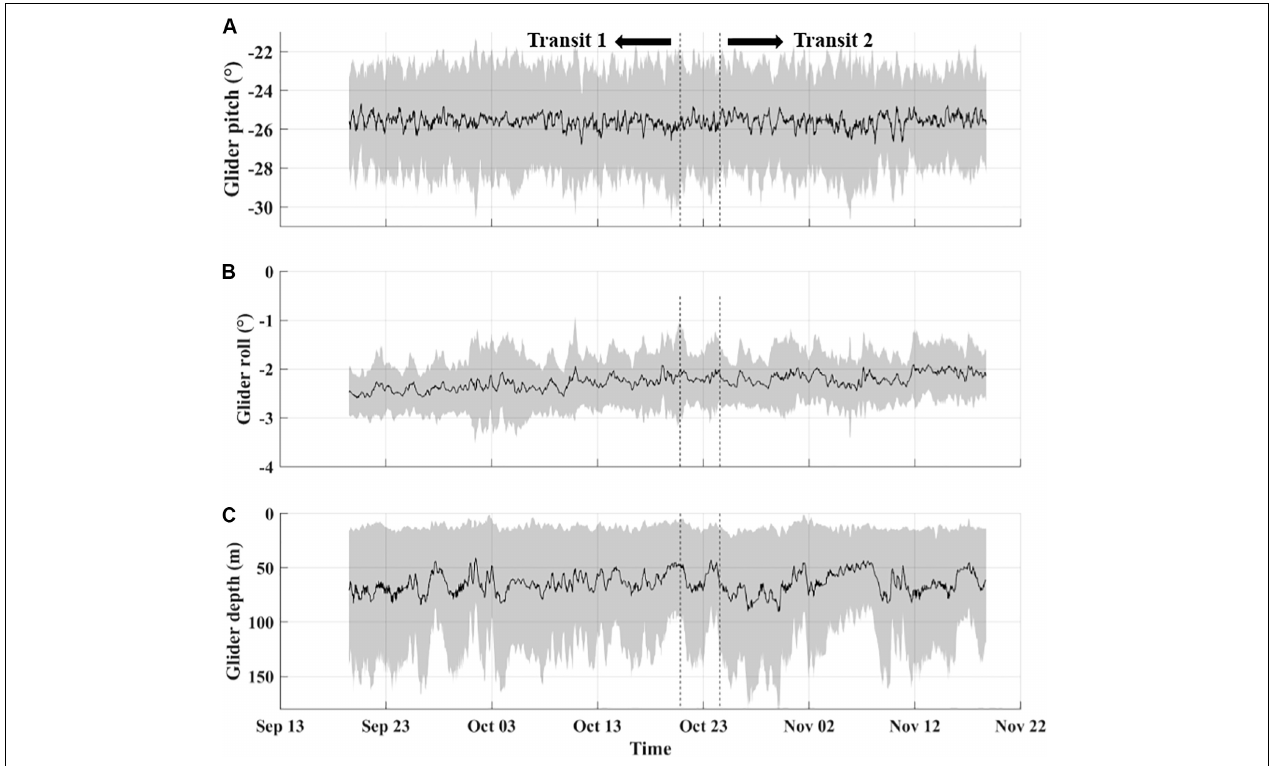
FIGURE 3 | Time series of glider pitch in degrees from horizontal (A) , roll in degrees from vertical (B) , and median depth in meters (C) during flight throughout the survey in Roseway Basin. Gray regions indicate standard deviations for panels (A,B) and maximum/minimum depths for panel (C) . Data shown is linearly interpolated with a window of 10